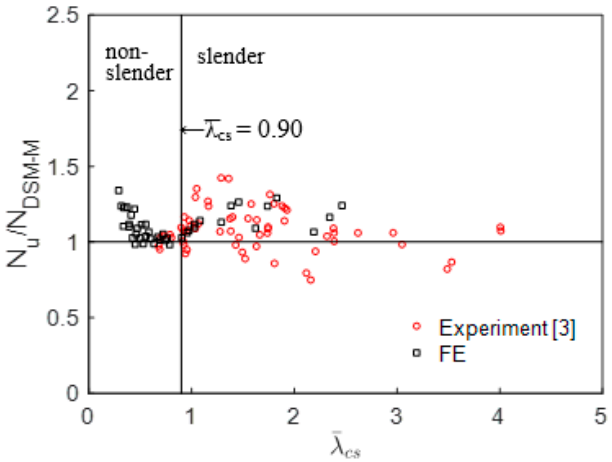
Figure 14. Assessment proposed modified DSM design strength predictions.